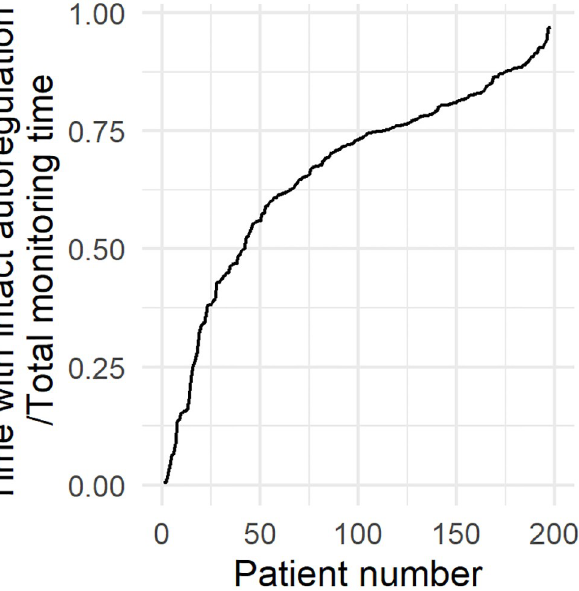
Fig 5. Fraction of monitoring time with intact autoregulation, per patient. All patients had both episodes of impaired and intact autoregulation, but to different extents. https://doi.org/10.1371/journal.pone.0243427.g005 and 25 mmHg compared to patients with favourable outcome, Fig 7A and Table 2, with PTD20 being 232.9 ( ± 750.8) vs 35.1 ( ± 64.5) mmHg � h respectively ( p = 0.014). On average, patients who died within 6 months post injury had a statistically significantly higher PTD above all ICP thresholds of 10 mmHg and above compared to survivors, Fig 7B and Table 2. The mean PTD above 20 mmHg was 493.4 ( ± 1125.6) vs 43.8 ( ± 84.7) mmHg � h ( p = 0.004).